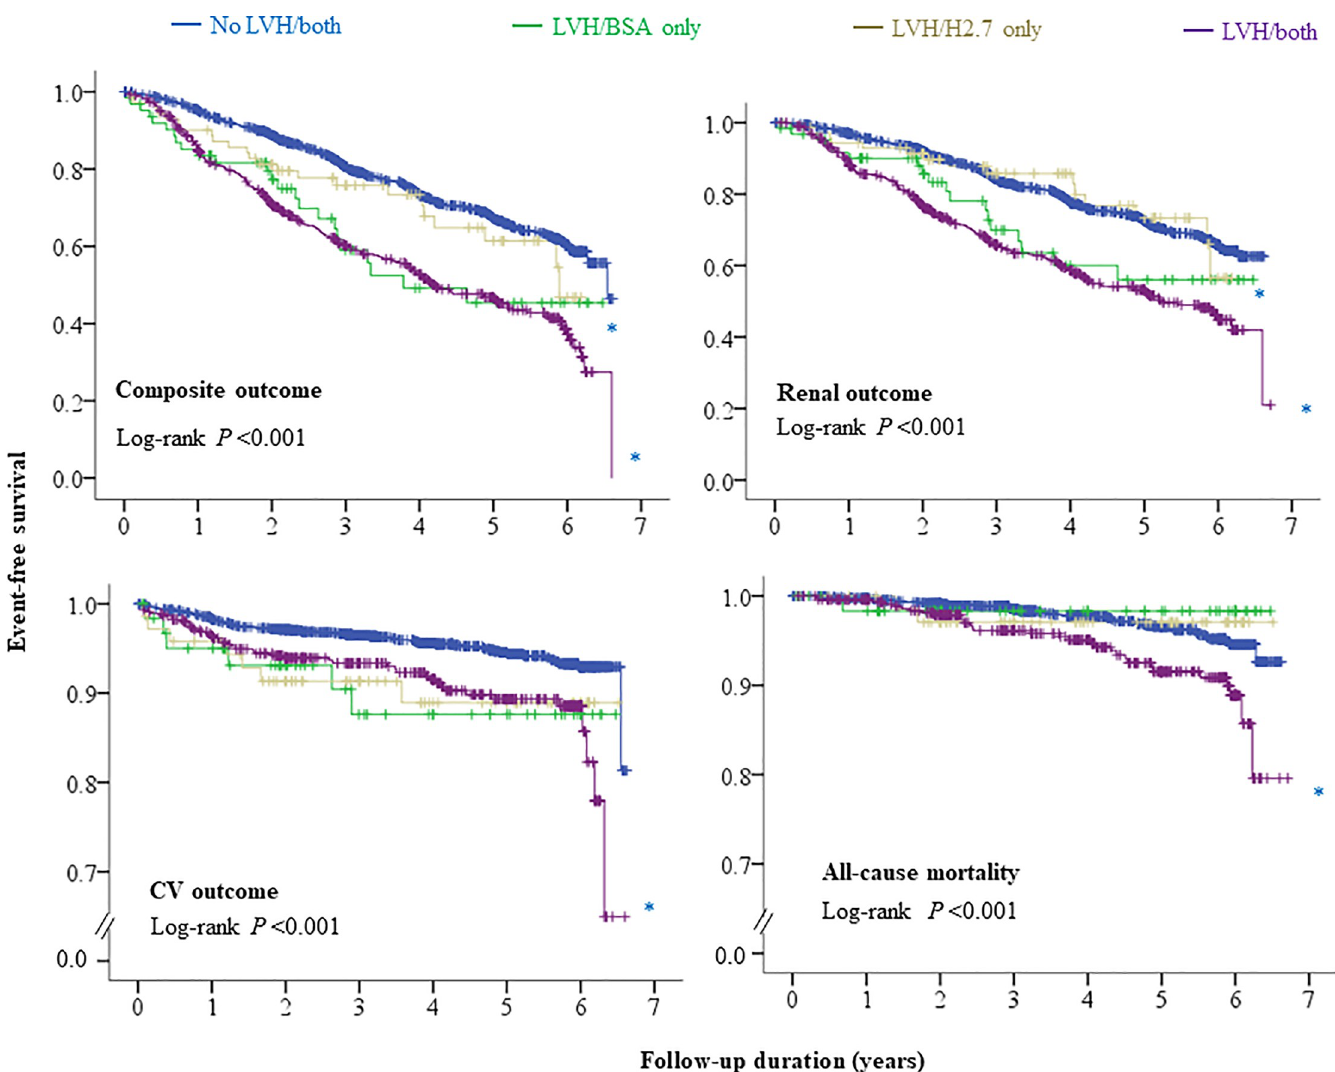
Fig 2. Kaplan Meier survival curve of left ventricular hypertrophy (LVH) groups defined by left ventricular mass index by body surface area (BSA) or height to the 2.7 power (H2.7) for adverse clinical outcomes. � , †, and ‡ meant P < 0.01 when compared to No LVH/both, LVH/BSA only, and LVH/H2.7 only groups, respectively, by using log-rank